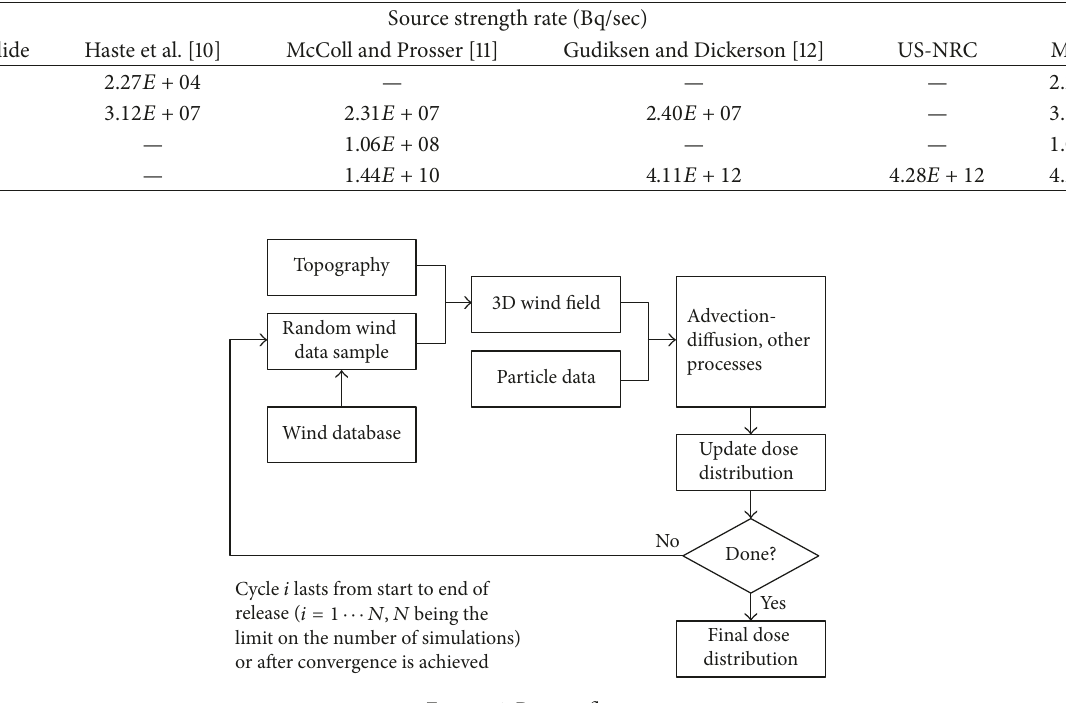
Figure 1: Process